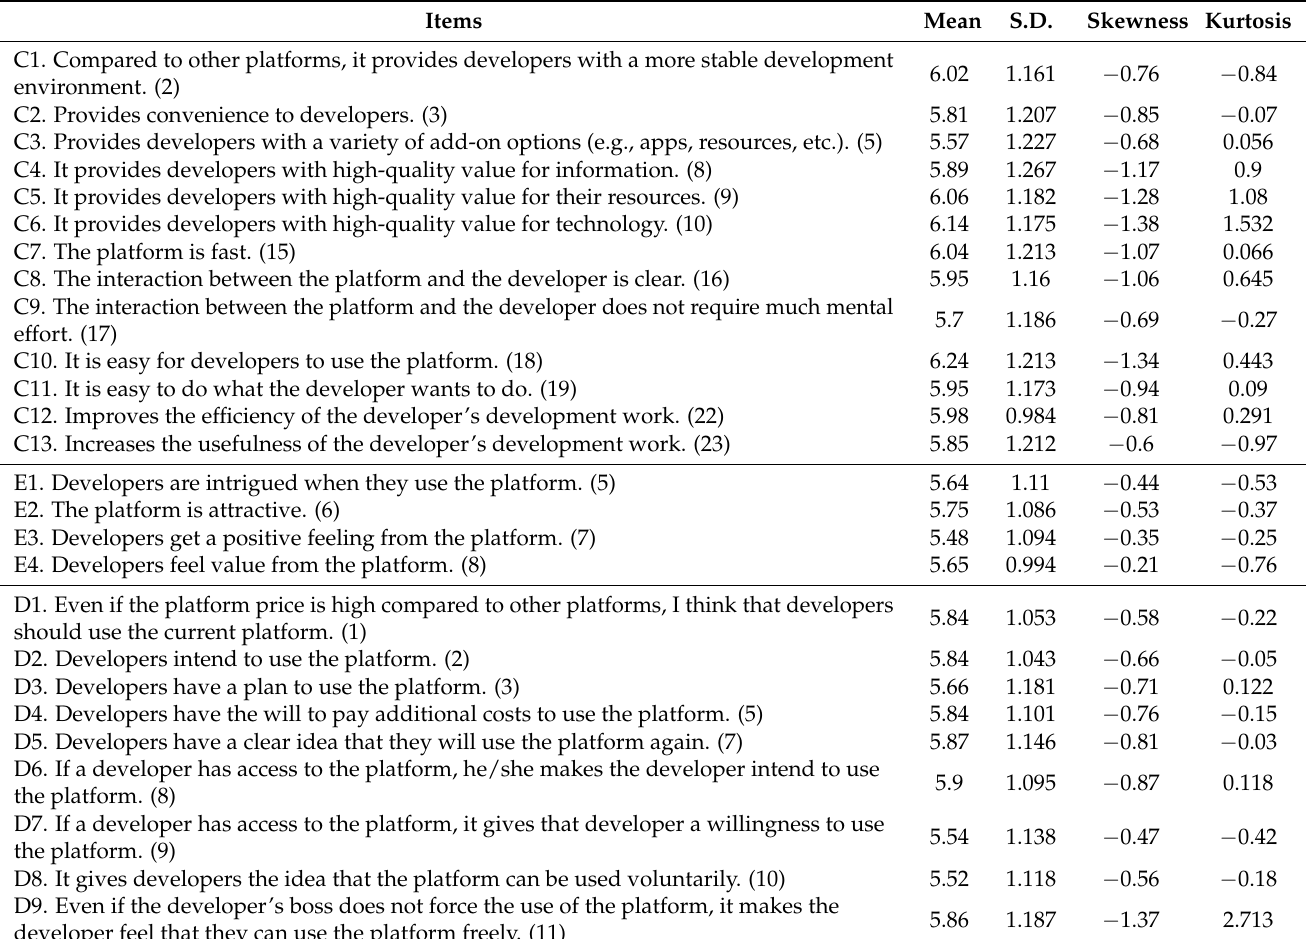
Table 5. Descriptive statistics for item measures: Mean, SD, Skewness,